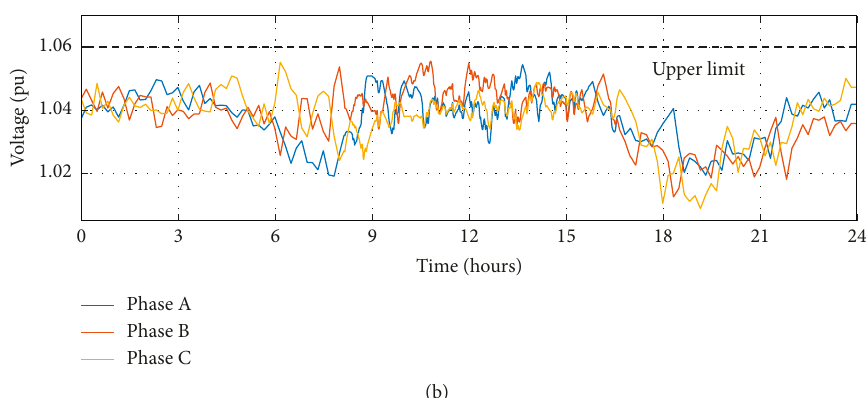
Figure 9: Voltage regulation performance with approximately balanced PV power integration: (a) constant power factor; (b) power factor droop curve.